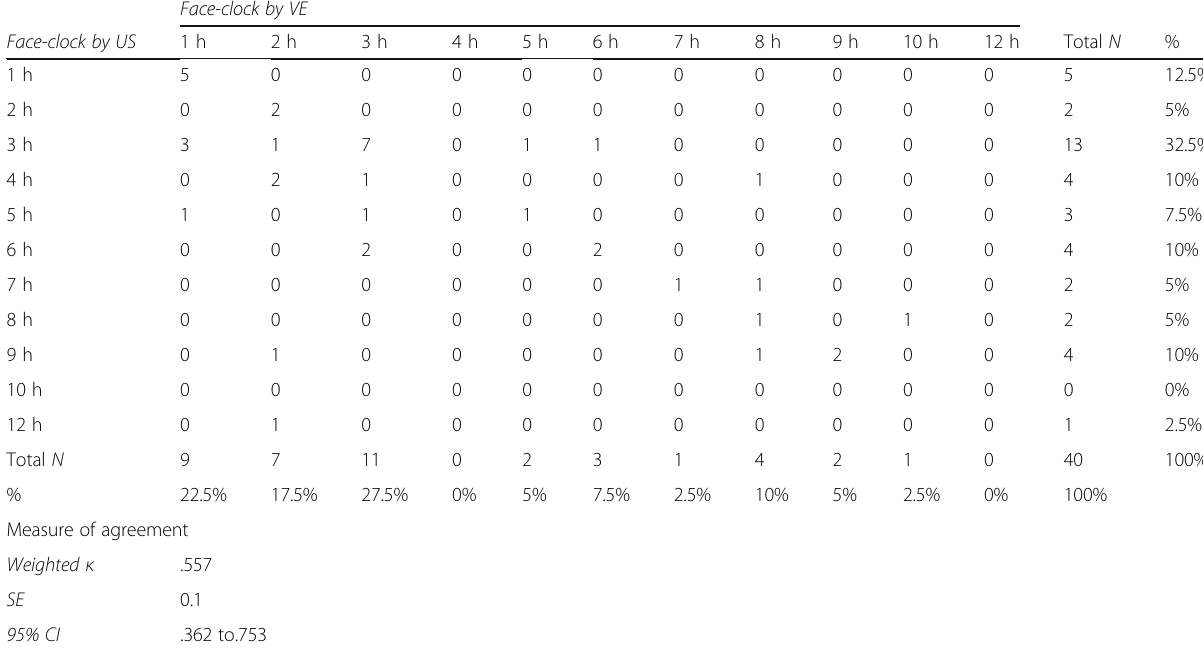
Table 1 Agreement between VE and US as regards the assessment of head position on face-clock Face-clock by